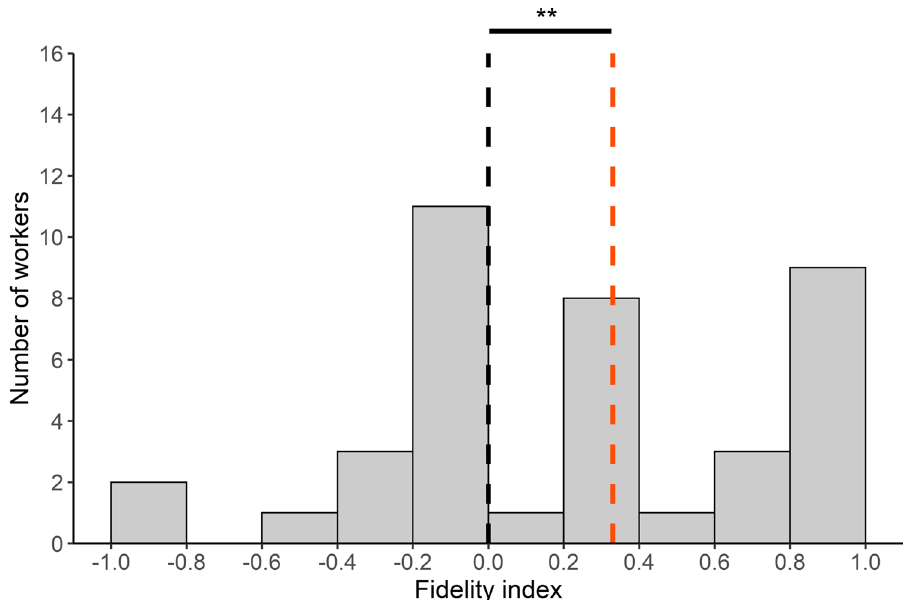
Figure 3. Individual experiment: distribution of the spatial fidelity indices for the foragers that performed several trips to the Y-maze (N = 39). The dotted orange line represents the median value of the observed individual fidelity indices and the dotted black line represents the value of 0 expected if the ants were as inclined to go toward the same platform as they were to switch between successive trips. One-sample Wilcoxon signed rank test; **: P <